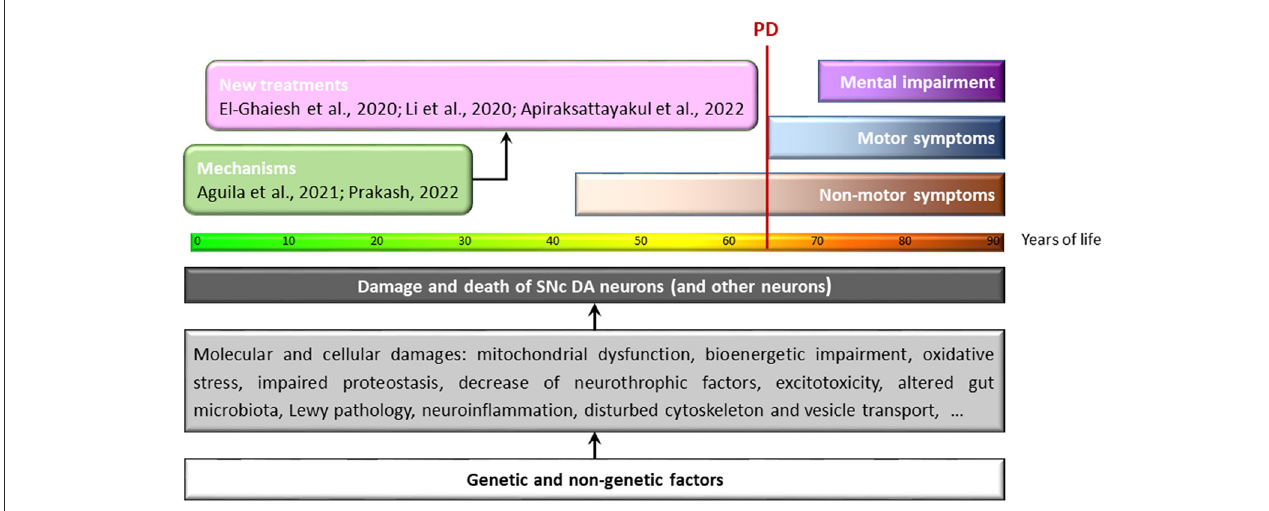
FIGURE1 Molecular and cellular damage that can lead to degeneration of SNc-DA neurons during the course of human life. Years of life: the progression of color in the bar represents the loss of functionality associated with the cellular aging process. Below this bar, some of the processes identified as harmful to DA neurons of the SNc (and other neurons) are summarized. These include processes initiated and maintained by genetic and non-genetic factors interacting in complex and hidden ways long before the first symptoms of the disease appear; the end result is the death of these neurons. Unfortunately, when motor symptoms appear—the first unmistakable signs of PD (vertical red line)—neuronal damage is extensive and irreversible. If we are to move beyond the temporary palliative maintenance of dopaminergic signaling that characterizes current treatments, we must identify the asymptomatic death of neurons early, discover the exact mechanisms that cause their death, and then use treatments that can prevent and/or stop neurodegeneration in the prodromal/asymptomatic stages of the disease. This Frontiers Research Topic includes a number of studies addressing either the molecular mechanisms of neurodegeneration (green box) or potential treatment options (pink